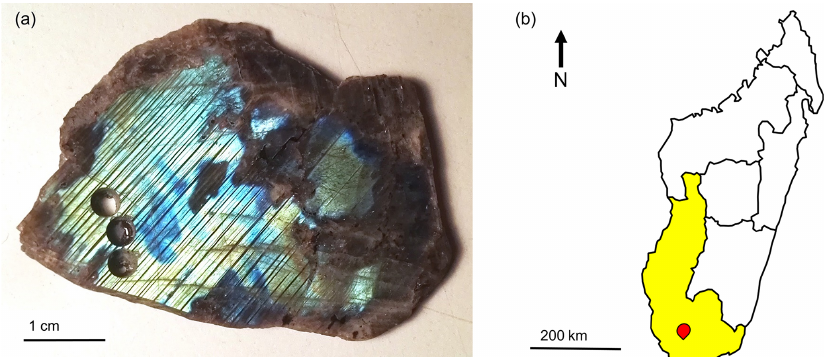
Figure 2. (a) Sample of labradorite displaying labradorescence ranging from dark blue to yellow. The samples were taken in a yellow area (lower left corner). Additionally, polysynthetic twinning can be seen. (b) Map of Madagascar with Toliara Province, the place of discovery of the labradorite, marked in yellow (ESRI, 2011). The sample shown in (a) is from the southern area of Ampanihy, Atsimo-Andrefana, marked in